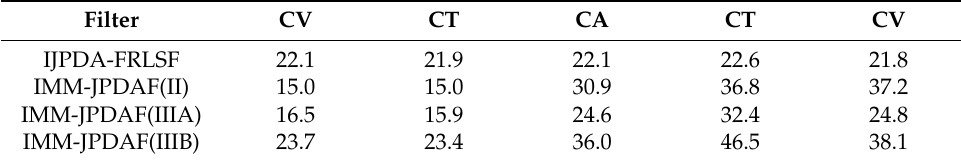
Table 3. The average root-mean-square (RMS) position error for Target II (unit: m). Filter CV CT CA CT